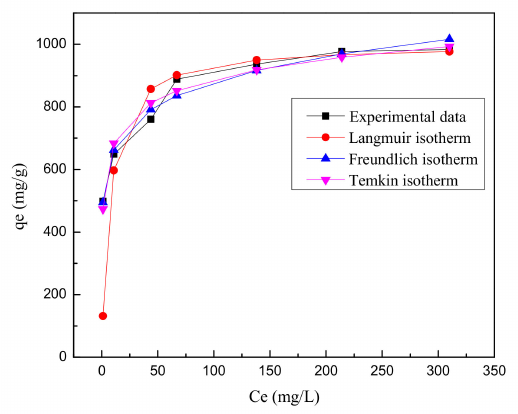
Figure 17. The isotherms for adsorption of MG onto nZVZ (initial pH = 5, temperature = 25 ◦ C and contact time = 120